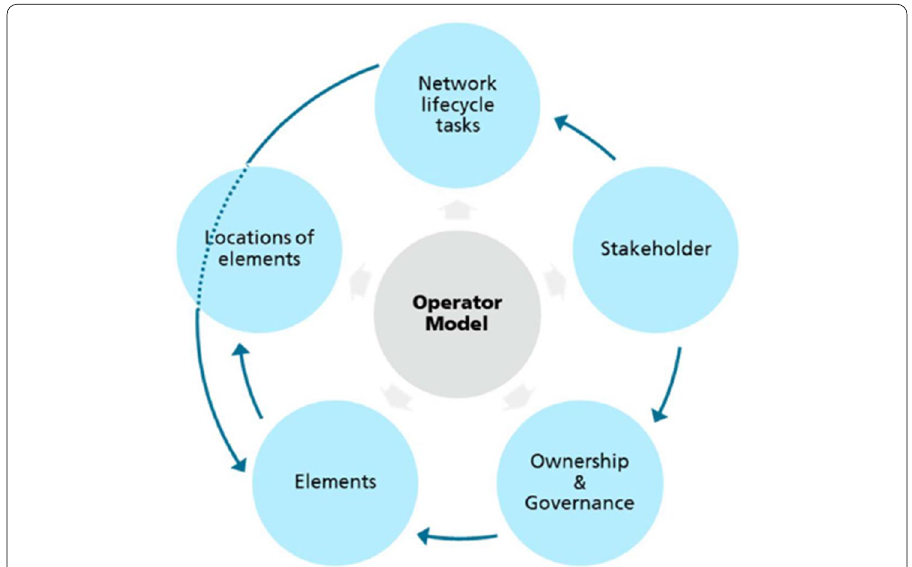
Fig. 5 Interrelation between Operation Model